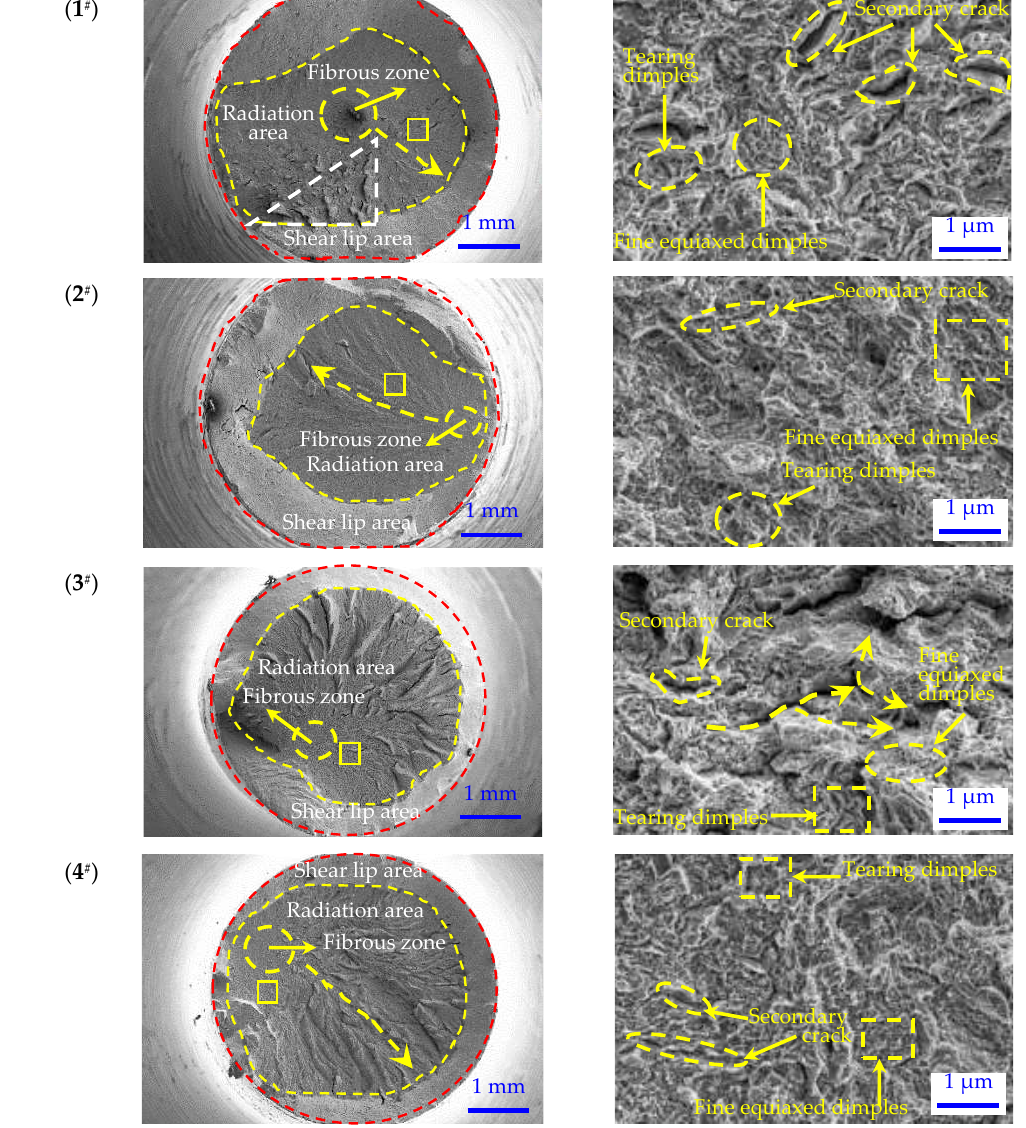
Figure 8. Micro and macro fracture morphologies of the steel samples.